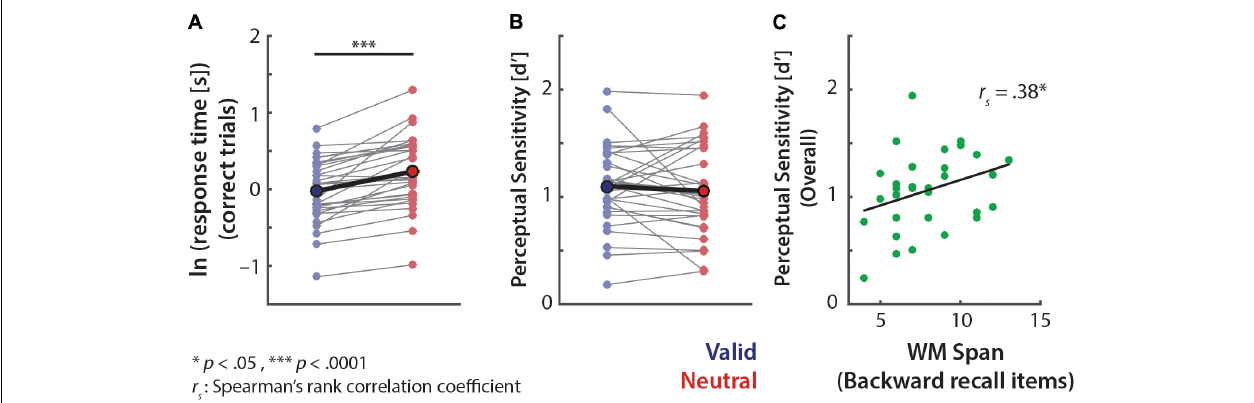
FIGURE 2 | Overall pitch-discrimination performance. Log-transformed response time of correct trials (A) and perceptual sensitivity d (cid:48) (B) . Data points connected by thin lines represent individuals’ performances. Mean performances are indicated by bold circles and bold lines. (C) Correlation between individuals’ backward auditory digit span scores and overall memory performances (i.e., overall d (cid:48) collapsed across all retro-cue conditions).